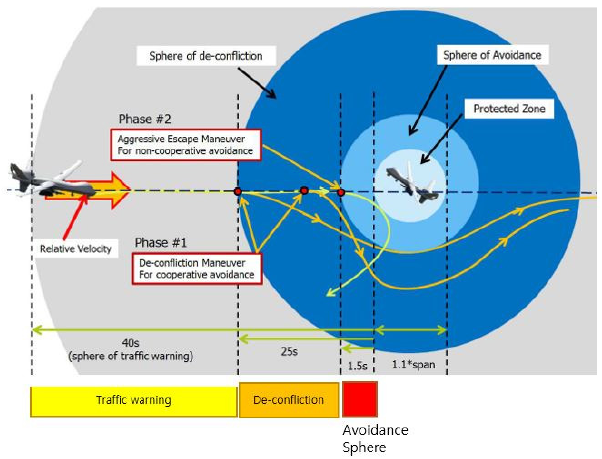
Figure 10. Concept of collision avoidance system structure on UAS.